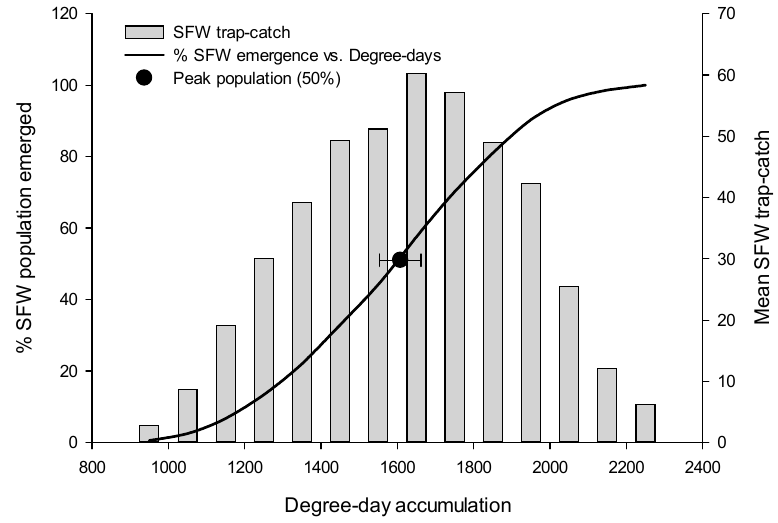
Figure 4. Sparganothis fruitworm (SFW) flight (% emergence, trap-catch, and peak flight) plotted as a function of degree-day accumulation. The peak flight interval (the halfway point, indicated by the black circle, ±95% CI) represents the range of degree-days within which peak flight is likely to occur. The A. vaccinii flight was last to peak, and this tended to occur around 1760 DD (95% CI: 1717–